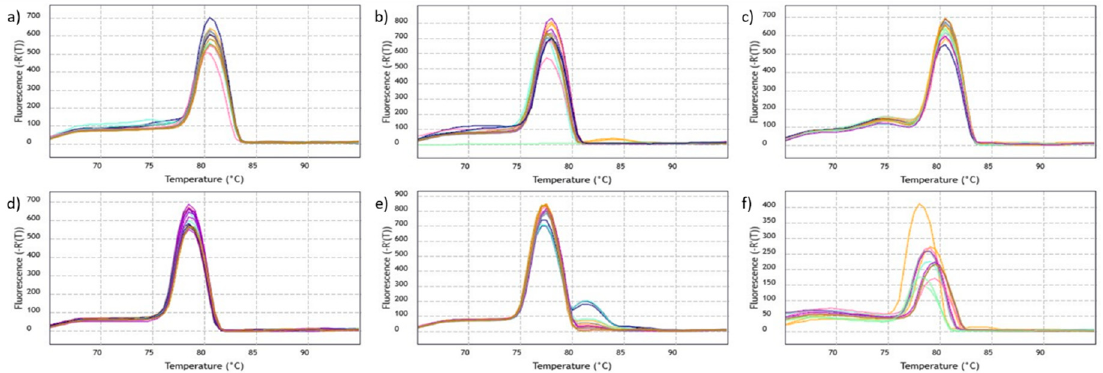
Figure 3. Melt curves of ATP1, COX2, GAPDH, MATK, NADH and RPOB gene primers: ( a ) ATP1 ; ( b ) COX2 ; ( c ) GAPDH ; ( d ) MATK ; ( e ) NADH ; ( f ) RPOB